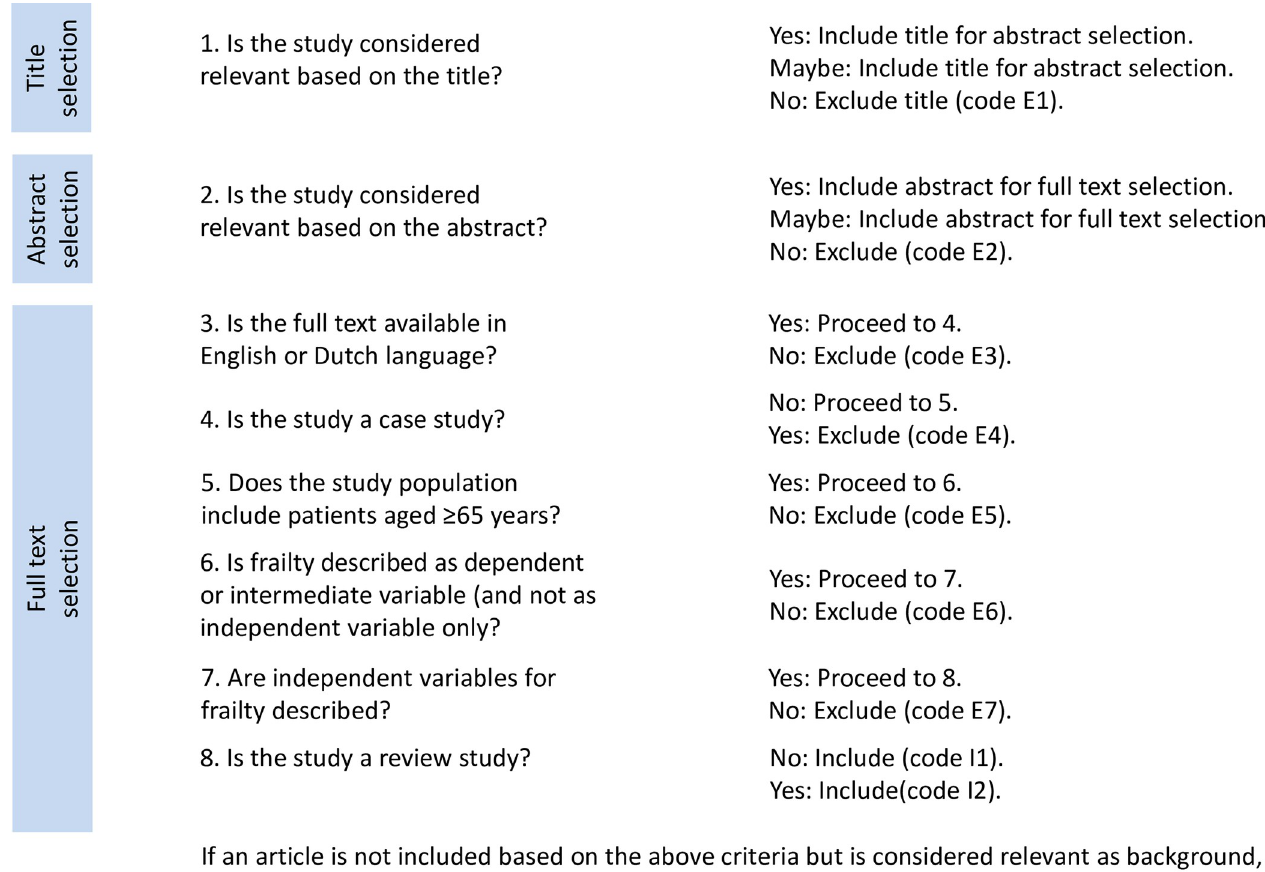
Fig 1. Selection process. The figure shows the selection process of the retrieved records.